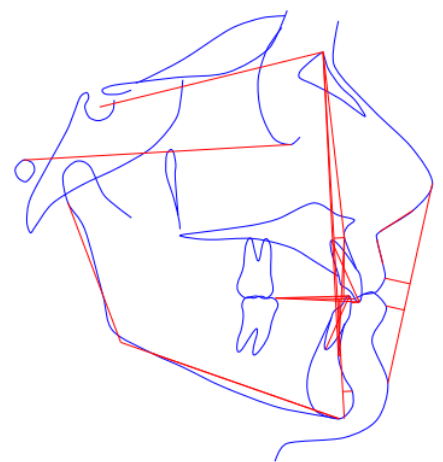
Figure 20. Post-treatment cephalometric tracing of case number 2. Table 4. Post-treatment cephalometric values of case number 2.